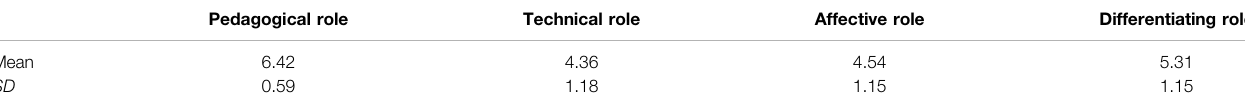
TABLE 2 | Mean scores for each